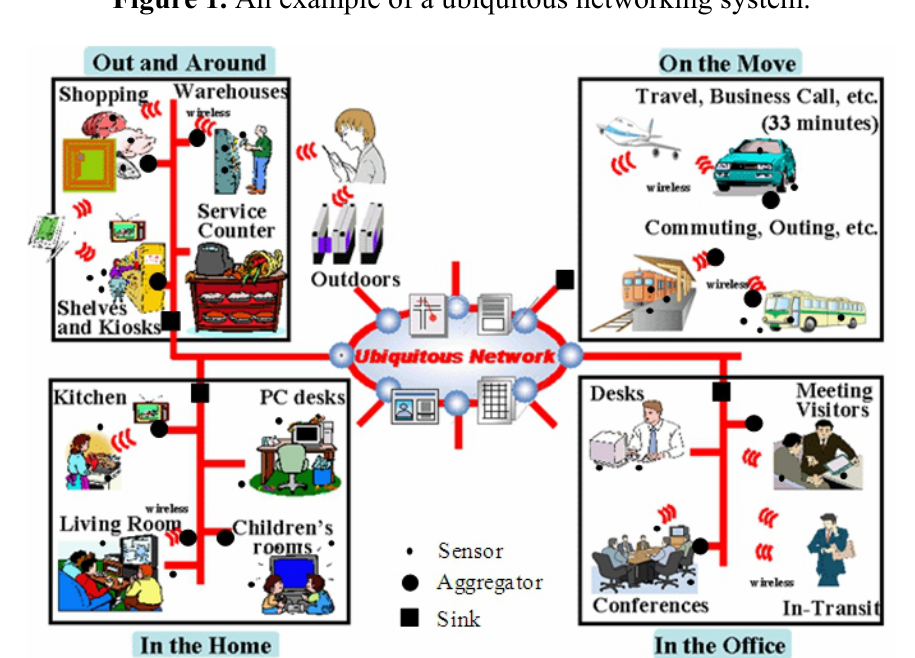
Figure 1. An example of a ubiquitous networking